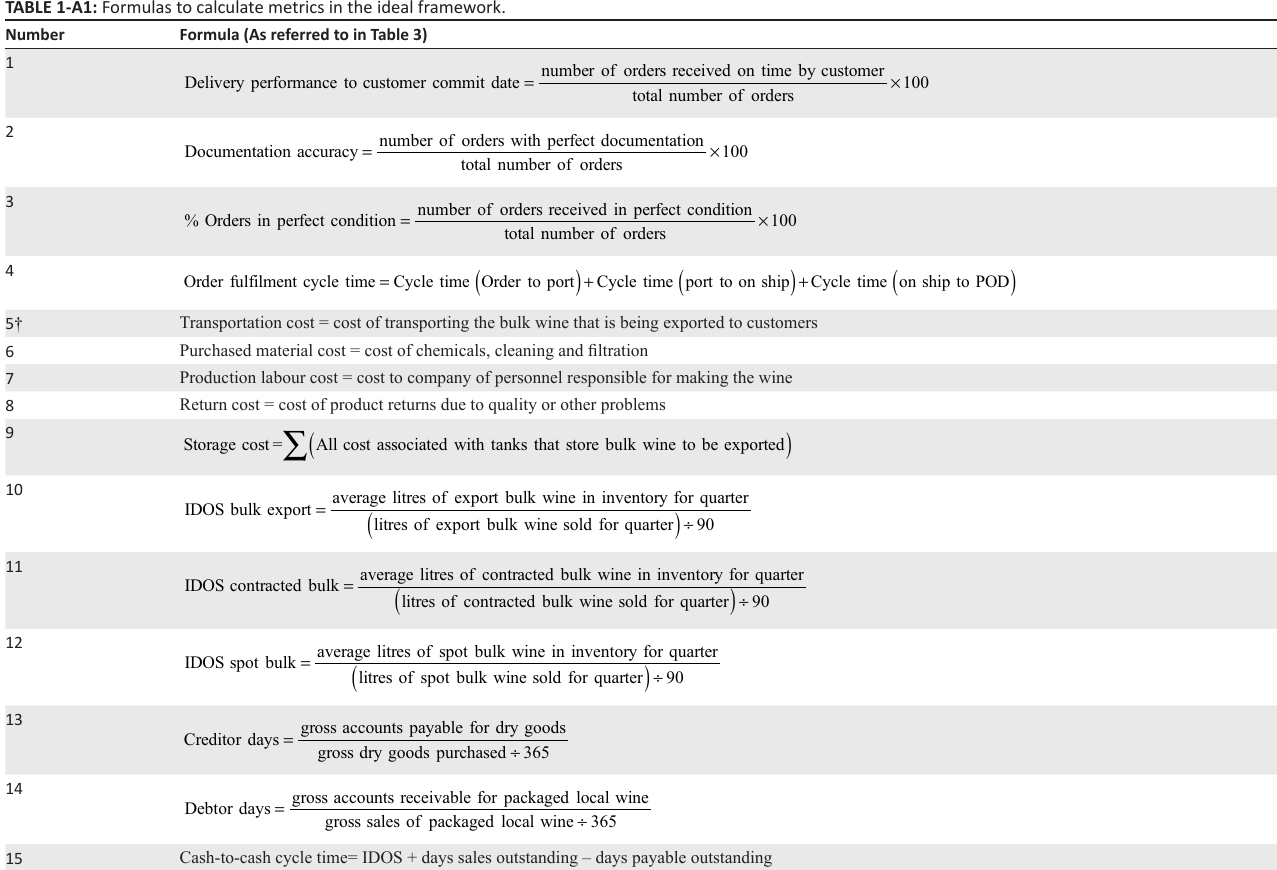
TABLE 1-A1: Formulas to calculate metrics in the ideal